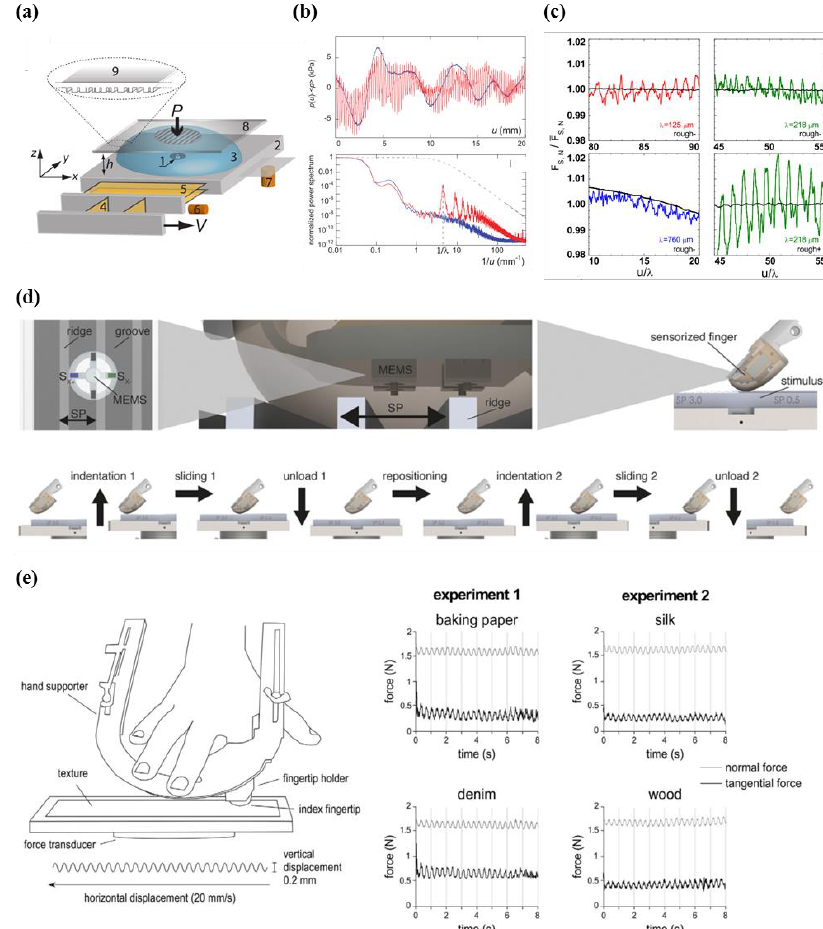
Figure 18. ( a ) Schematic illustration of the measurement setup (left); ( b ) plot of pressure variation according to the displacement (smooth and fingerprinted fingers) (top). Output data of power spectra of signals from Fourier transform (bottom) (reprinted with permission for Figure 18a,b from Ref. [156] Copyright 2009 The American Association for the Advancement of Science); ( c ) plot showing the fluctuations (tangential force) with respect to μ/λ (reprinted with permission for Figure 18c from Ref. [157] Copyright 2011 American Physical Society). ( d ) Schematic illustration showing experimental setup and flow by using sensorized finger (reprinted with permission for Figure 18d from Ref. [9] under CC-BY 4.0 license); ( e ) illustration of experimental setup and tools (left), measured force as a function of time at various texture (baking paper, silk, denim, and wood) (right) (reprinted with permission for Figure 18e from Ref. [160] under CC-BY 4.0 license).